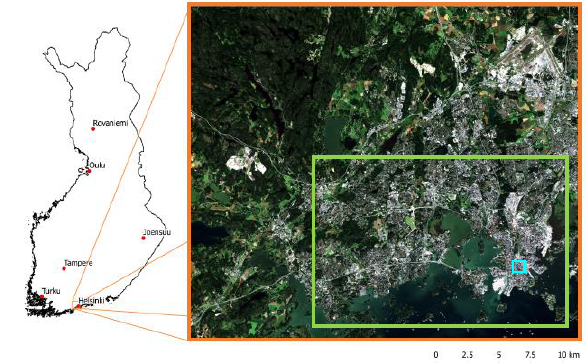
Figure 1: Area of investigation defined by the corner coordinates 60  21’30’’N, 25  02’21’’E and 60  06’30’’N, 24  28’21’’E with subareas of Helsinki and Espoo (green) and downtown Helsinki (turquoise)